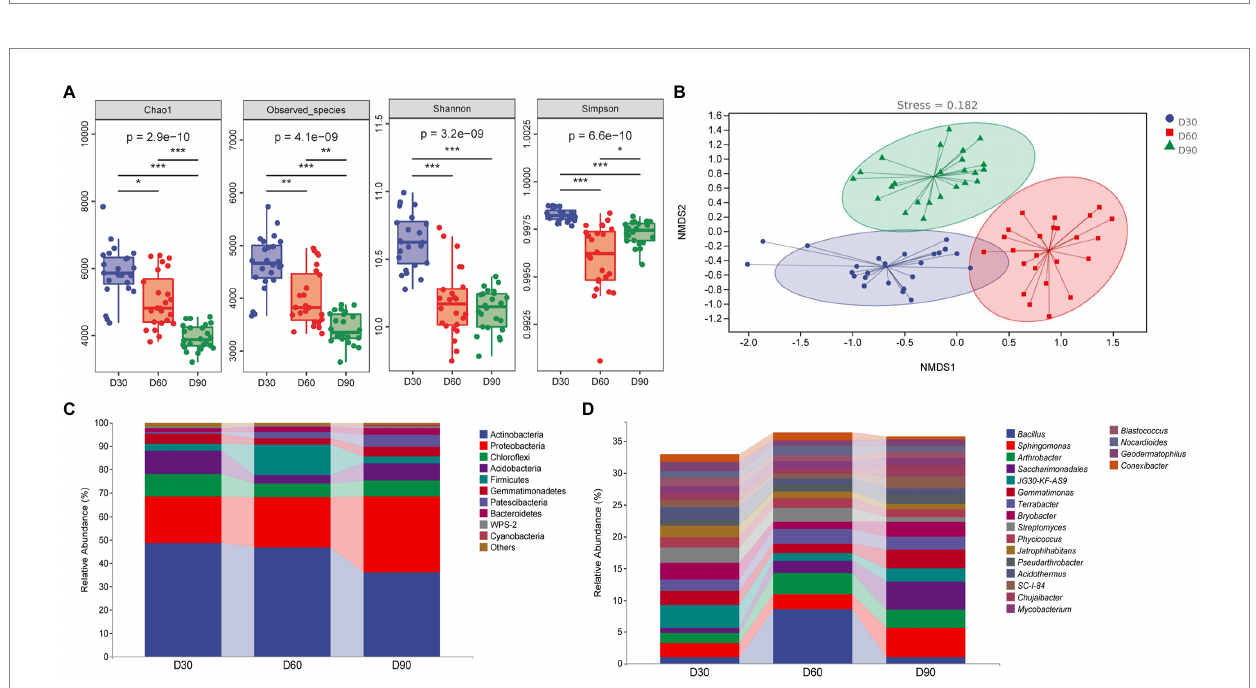
FIGURE 2 Diversity analysis of the rhizosphere microbiota of flue-cured tobacco at different transplantation stages. (A) . Alpha diversity of the rhizosphere microbiota of flue-cured tobacco. (B) . Nonmetric multidimensional scaling (NMDS) of rhizosphere microbiota of the flue-cured tobacco. (C) . Composition and distribution of rhizosphere microbiota of flue-cured tobacco at the phylum level. (D) . Composition and distribution of rhizosphere microbiota of flue-cured tobacco at the genus